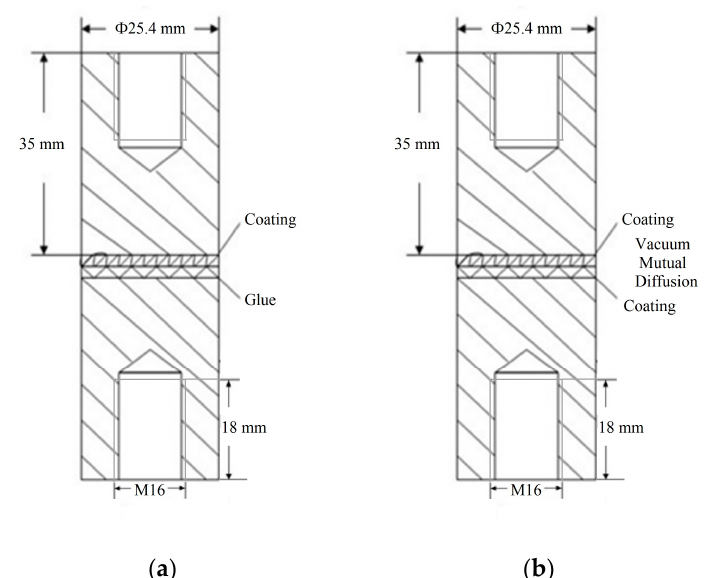
Figure 3. Schematic of adhesion strength testing: ( a ) room temperature; ( b ) high temperature.